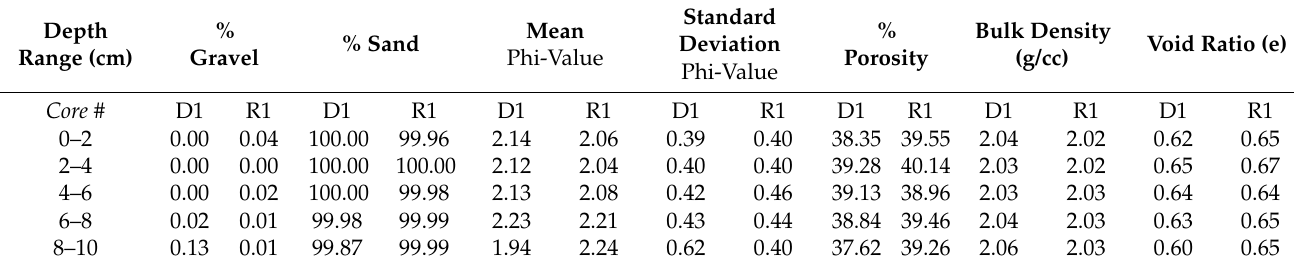
Table 2. Sediment properties from diver push cores taken during the deployment (D1) and the retrieval (R1) of the instrumentation at the shallow quadpod location (from [13]). Depth Range